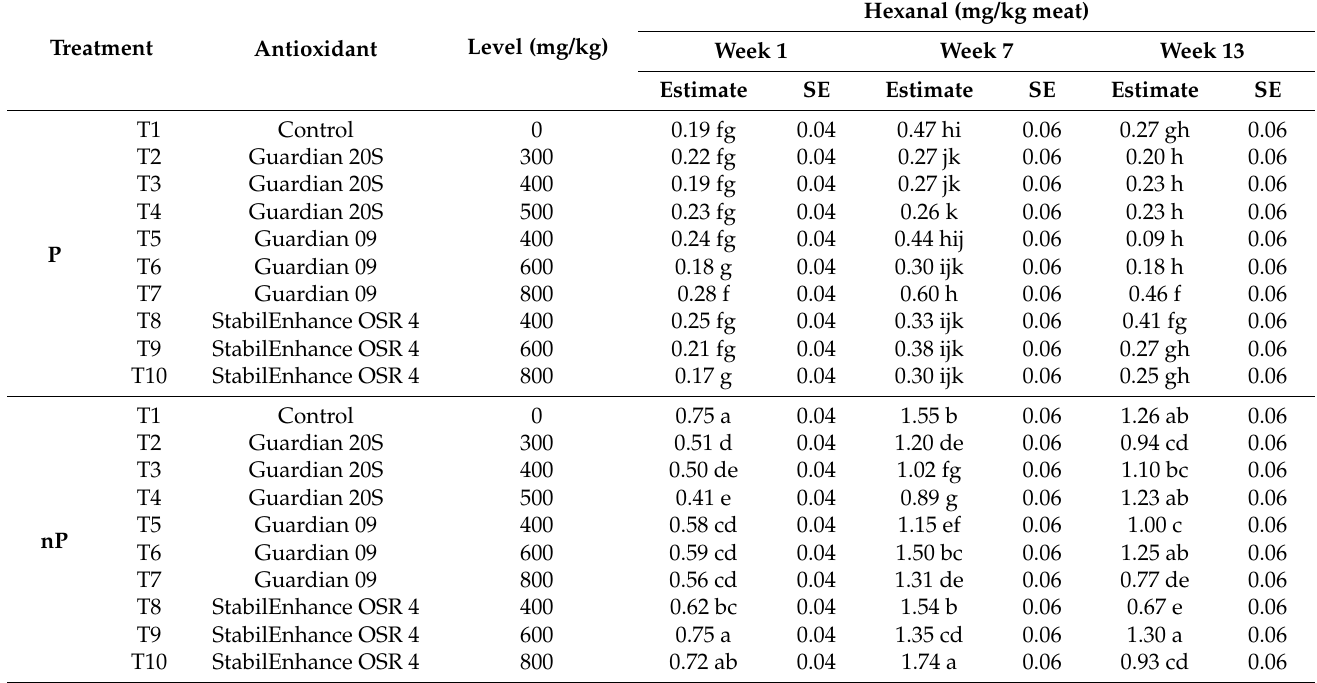
Table 3. Hexanal content (mg/kg meat) (mean of three samples) in pulled pork with or without phosphate. Estimate in- dicates the mean hexanal content for triplicate determinations. Means with different letters within each week indicate significant difference ( p ≤ 0.05) between treatments. P = samples with phosphate, nP = samples without